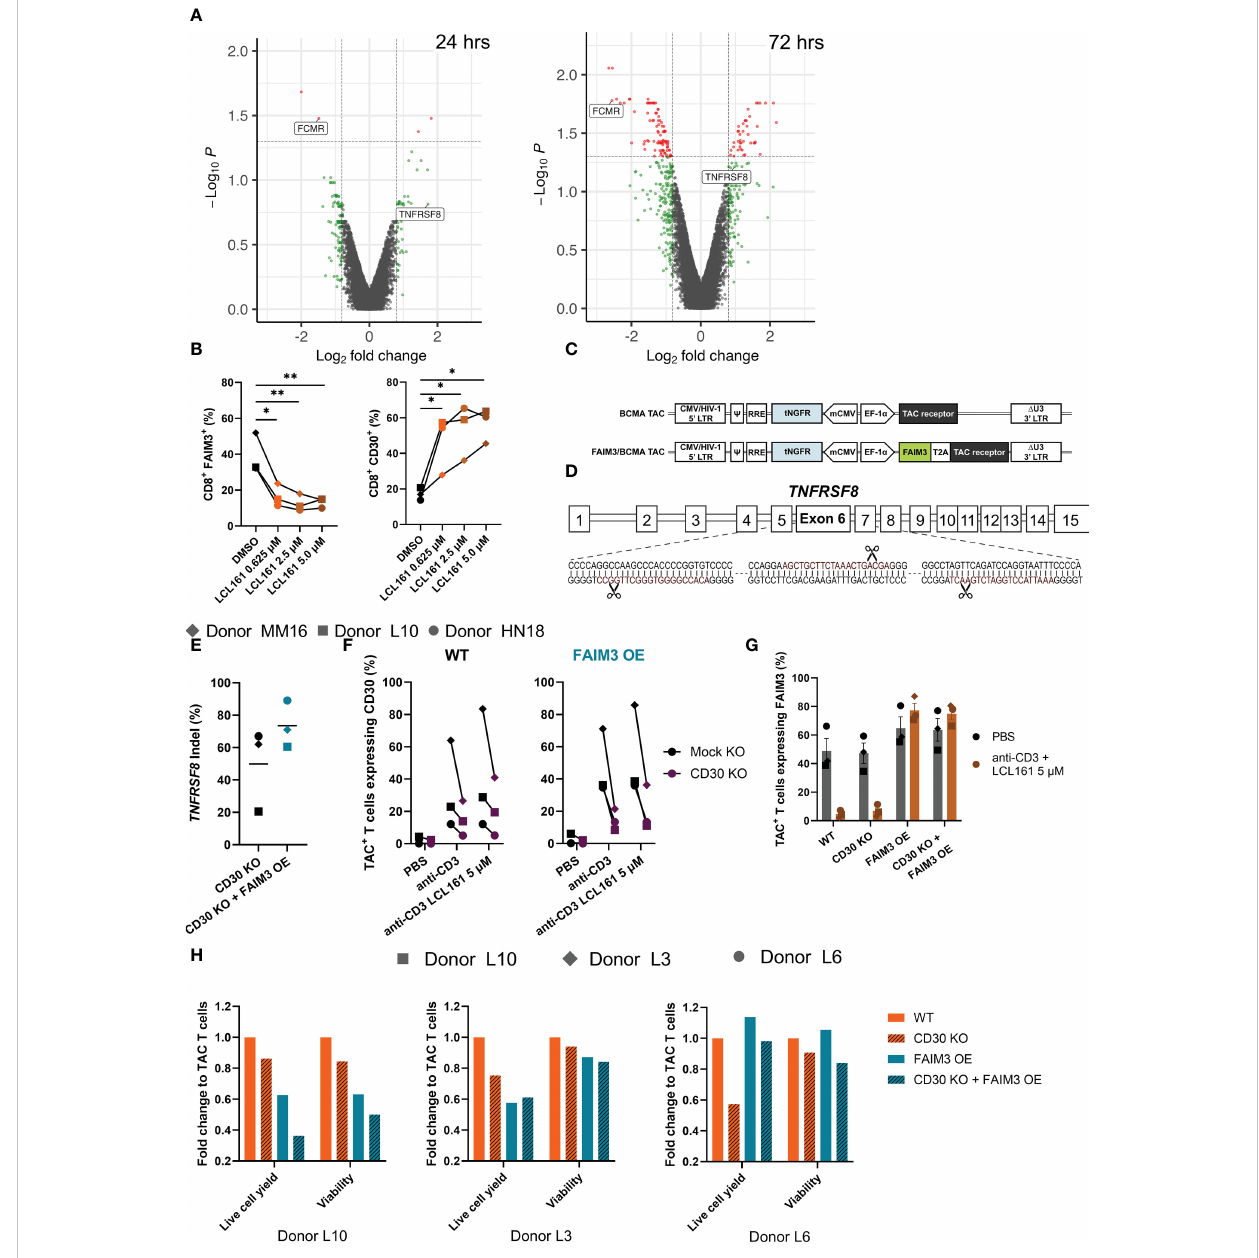
FIGURE 3 FAIM3 and CD30 mediate, in part, the costimulatory mechanisms of LCL161 in enhancing TAC T cell proliferation. (A) Cryopreserved TAC T cells were thawed into complete media, rested for 24 hrs, then 5x10 5 T cells were stimulated by 0.05 m g/mL plate-bound BCMA antigen for 24 or 72 hrs in the presence of DMSO or LCL161. After stimulation, cells were collected, homogenized, and RNA was collected. Transcripts were assessed using a Clariom-S Pico human genechip. n=3, 1 per donor (HN18, L10, MM16). Volcano plots of the 24 and 72 hour Clariom data were generated using a p- value threshold of 0.05 (red dots) and fold change of 1.75 (red or green dots). (B) Thawed and rested cryopreserved TAC T cells were stimulated for 72 hrs with BCMA-coated microbeads and LCL161 or vehicle. Cells were collected, stained, and analyzed by fl ow cytometry for FAIM3 and CD30 expression. (C) Schematic diagram of FAIM3 cDNA separated by a T2A sequence upstream of the TAC receptor within the lentiviral vector. (D) TNFRSF8 was deleted by triple gRNA editing with CRISPR/Cas9, schematic indicates the sequence of gRNA (in red) and cut sites on the targeted exon. (E-H) BCMA TAC T cells ± FAIM3 overexpression (OE) were cultured as normal and edited on day 3 with CD30 multi-guide or negative control gRNA/Cas9 RNP by Neon electroporation. T cells were then cultured until day 14-15 and utilized fresh in assays. (E) TAC T cell genomic DNA was collected on day 13-14 of culture by extraction with Lucigen DNA extraction solution. The TNFRSF8 exon 6 locus was ampli fi ed by PCR, sequenced by sanger sequencing, and indel frequency was computed using Synthego ICE. (F-G) BCMA TAC T cells ± FAIM3 OE were stimulated using 1 m g/mL plate-bound agonistic anti-CD3 antibody ± 5 m M LCL161 for 24 hrs (donor L10) or 72 hrs (donors L3 and L6). After stimulation T cells were collected and stained for (F) CD30 and (G) FAIM3 expression and analyzed by fl ow cytometry. (H) CTV-labelled TAC T cells were stimulated with 0.625 m M LCL161 and BCMA-coated microbeads at an E:T 1:1 for 96 hrs then analyzed by fl ow cytometry. Data was modeled using FCS Express 7 and values were normalized to wildtype TAC T cells. n=3. The data in panel B represent 1 independent experiment. The data in panels E – H represent 3 independent